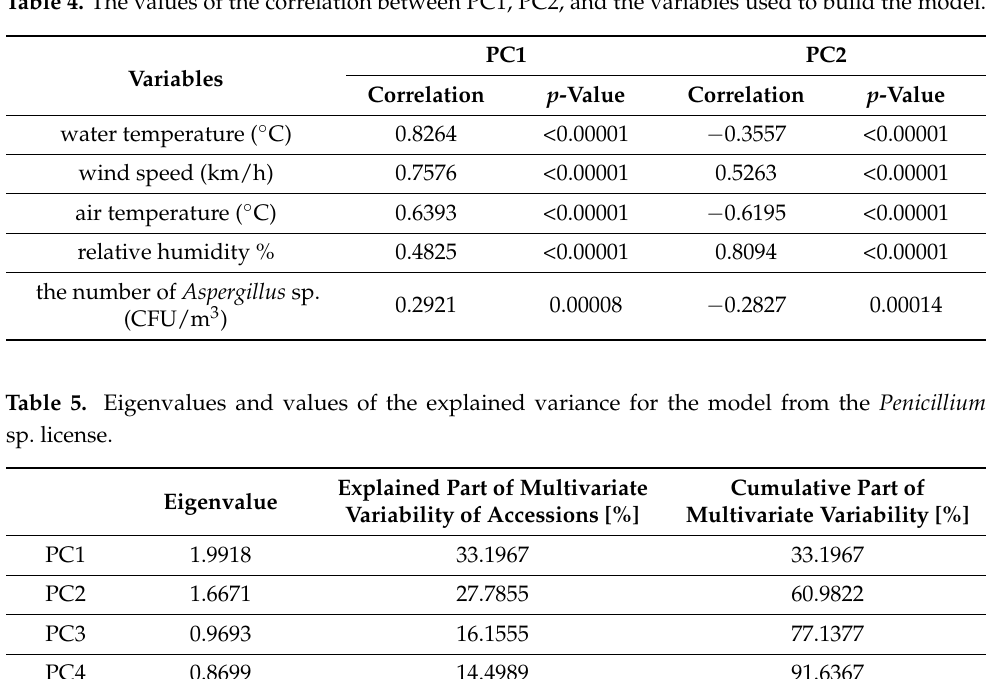
Table 4. The values of the correlation between PC1, PC2, and the variables used to build the model.